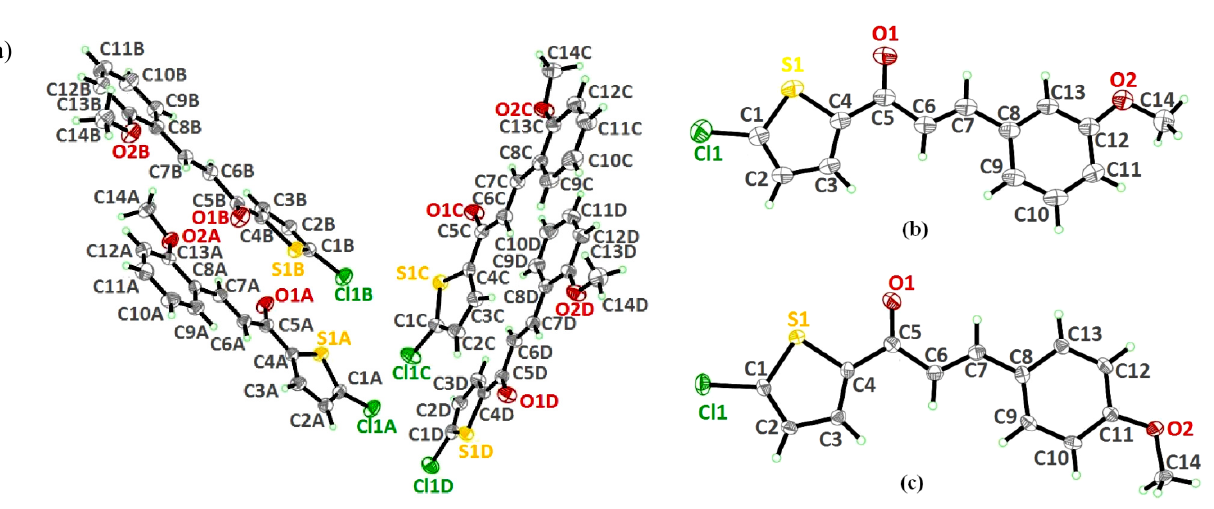
Figure 5. Molecular structure of compounds ( a ) 4d , ( b ) 4e and ( c ) 4f , with atom numbering schemes. Displacement ellipsoids are drawn at the 30% probability level.